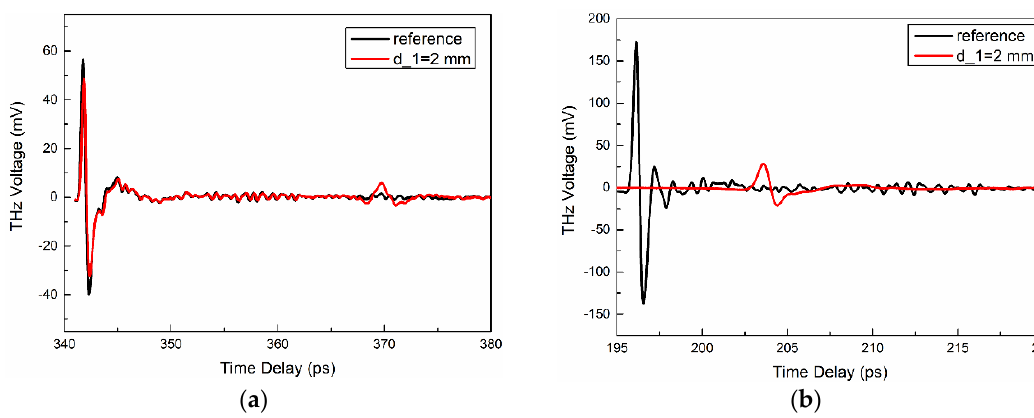
Figure 5. THz time ‐ domain spectra of the reference and the flaked stone thickness of 2 mm. The time ‐ domain spectra of ( a ) were obtained from the THz reflector system, with the transmission THz system for ( b ).